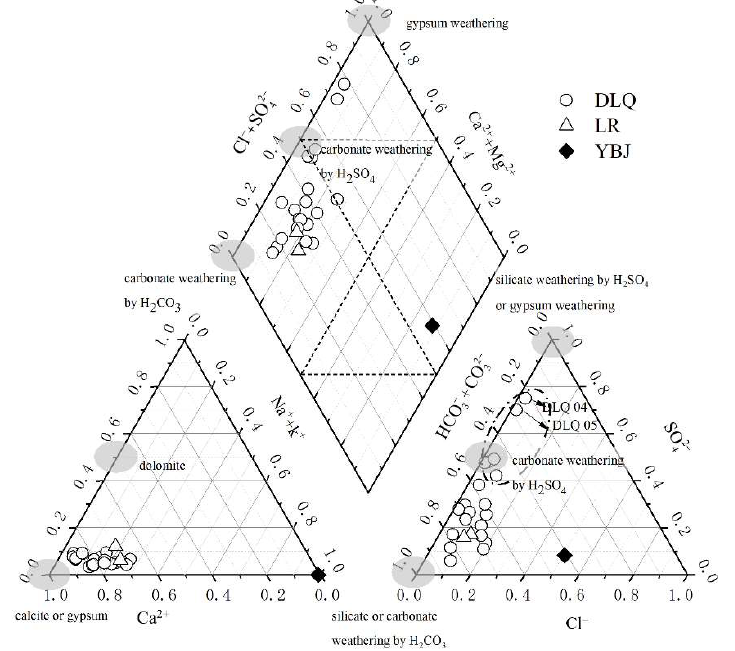
Figure 2. Piper diagram showing major ion compositions of the river waters. The end-members were taken from Spence and Telmer [53] and Li et al. [48].